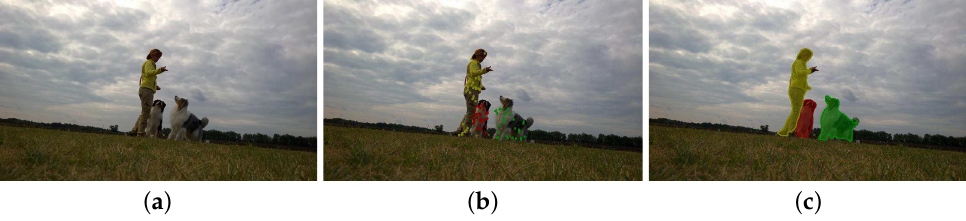
Figure 5. Examples of weakly supervised VOS: ( a ) inputs, ( b ) point clicks, and ( c ) segmentation results.